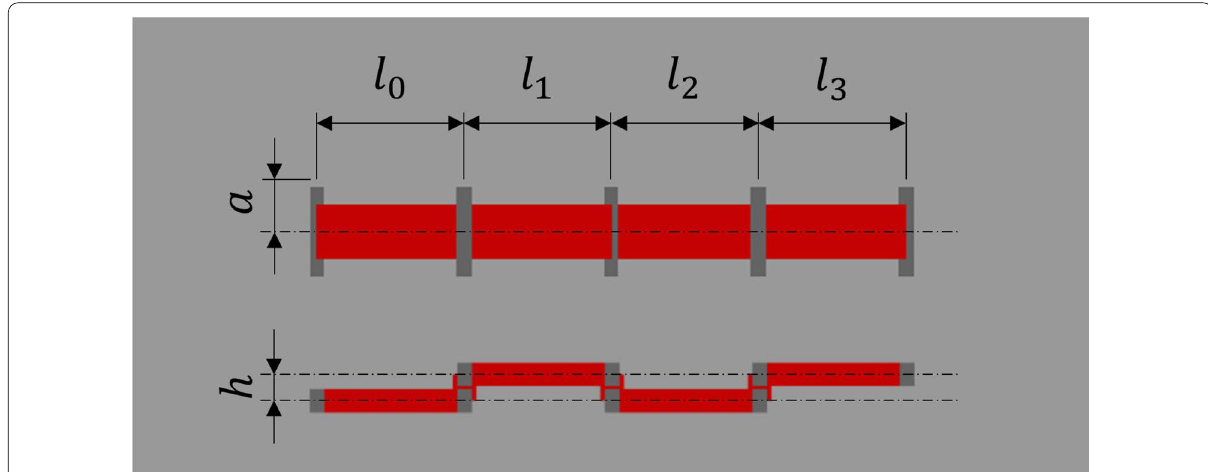
Fig. 4 Diagram of multi-serial-link mechanism